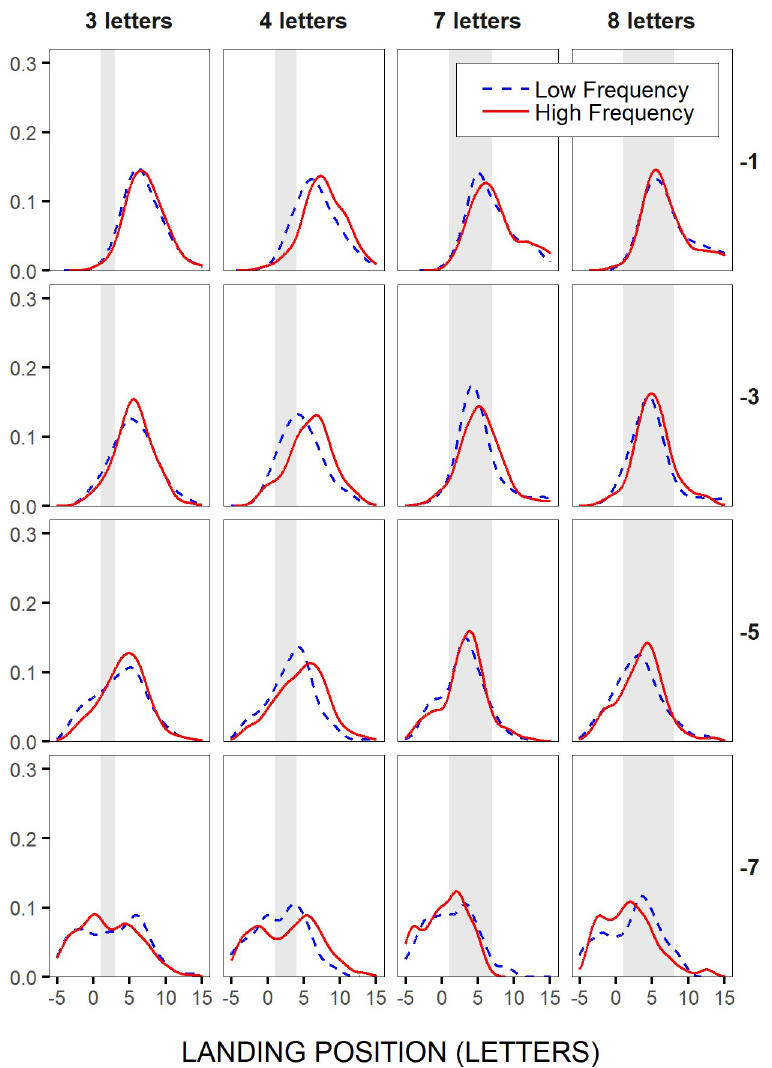
Fig 11. Overall landing-position distributions. Across-participants probability density functions (bandwidth: 1 letter or 0.25˚; Gaussian Kernel) of all saccades’ landing positions regardless of word boundaries (or overall landing positions), expressed in letters relative to the beginning of Word N+1 (i.e., the word immediately to the right of the word (N) from which the saccade was launched), with positive values corresponding to landing positions on this word or beyond it, and negative values corresponding to landing positions in front of the word, and hence refixations of Word N. Distributions were plotted, using all words in the sentences that responded to our selection criteria (see Text), separately for short and long N+1 words (3–4 and 7–8 letters in left and right panels respectively), different saccadic launch-site distances (in letters relative to the space in front of Word N+1), binned in two-letter intervals (from upper to lower panels: [0,-2[, [-2,-4[, [-4,-6[, [-6,-8[, referred to as -1,-3,-5 and -7 respectively), and for high vs. low-frequency N+1 words (i.e., the words that fell respectively within the two most extreme categories of word frequencies when grouped into three bins; see Materials and Methods). Light-grey rectangle areas represent the horizontal extent of the words.